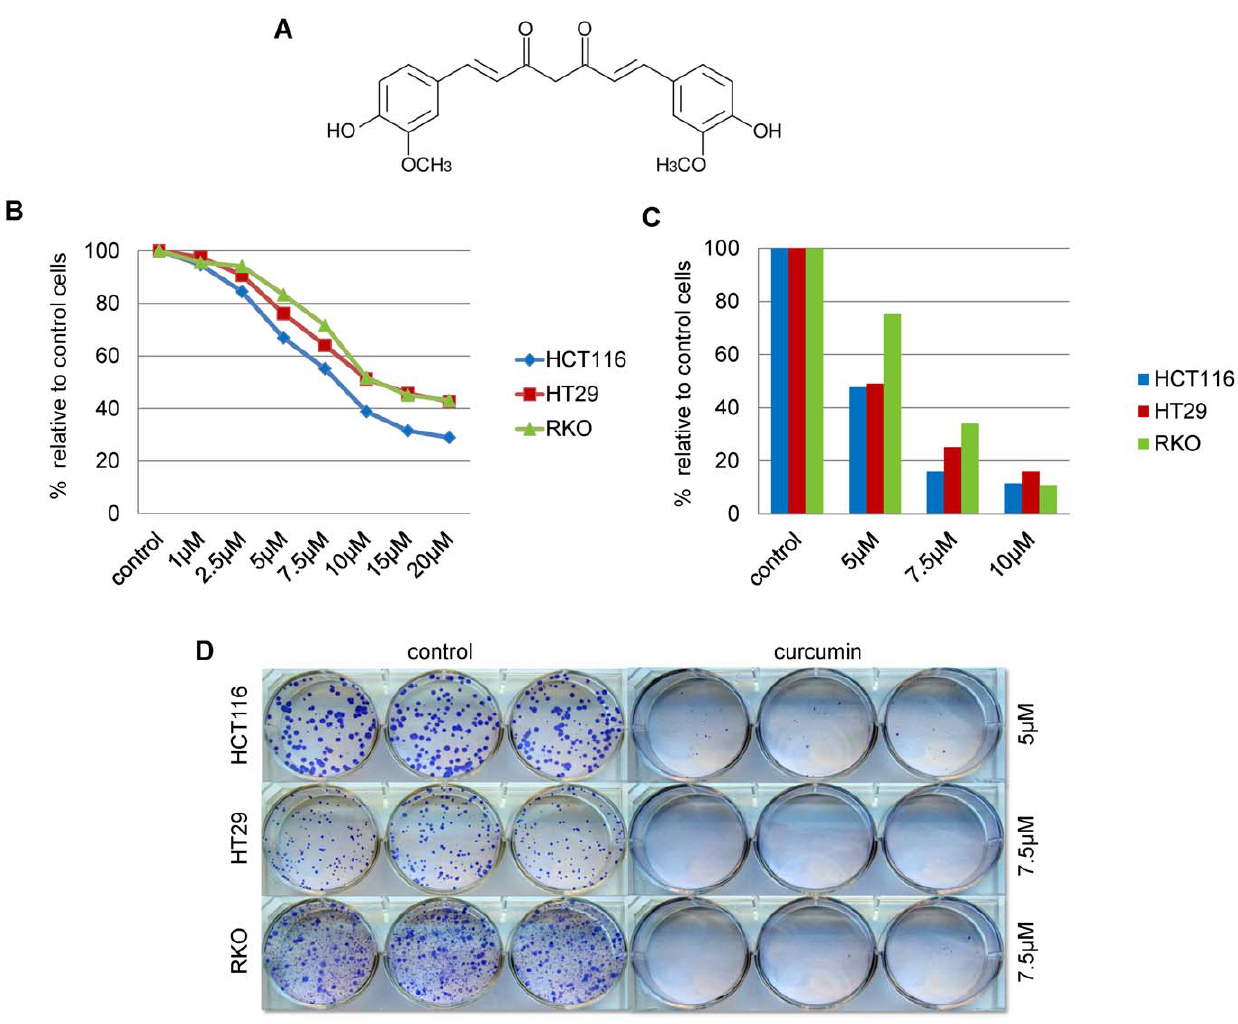
Figure 1. Curcumin inhibits cell viability, proliferation and colony formation of CRC cells. (A) Chemical structure of curcumin: (1 E ,6 E )-1,7- bis(4-hydroxy-3-methoxyphenyl)-1,6-heptadiene-3,5-dione. (B) MTT and (C) BrdU assays were performed to determine the best effective sub-toxic concentration of curcumin. CRC cells were treated with curcumin at various concentrations for 72 h (data represent the mean of independent experiments performed in triplicate). (D) The long-term anti-proliferative effects were evaluated in a colony formation assay. The cells were treated with curcumin for 12 to 16 days until distinct colonies were visible. Representative images of from an experiment illustrating colony formation results in controls (DMSO treated) and curcumin-treated HCT116, RKO and HT29 cancer cells. min treatments are represented as red and blue dots, respectively. The vertical distances of each dot from the ‘‘line depicting results from the control cells’’ represent the level of either hyper- (above the white line) or hypo-methylation (below the white line). As shown in Figure 2B, short-term curcumin treatment was associated with relatively minor methylation changes in all 3 cell lines, with the corresponding mean b -value changes as follows; 0.389 vs. 0.393 for HCT116, 0.388 vs. 0.396 for RKO and 0.294 vs. 0.291 for HT29. In contrast, long-term curcumin treatment was associated with more pronounced methylation changes compared to control cells ( Figure 2B ), although the net b -value change was not significantly different (0.399 for HCT116, 0.398 for RKO and 0.275 for HT29).